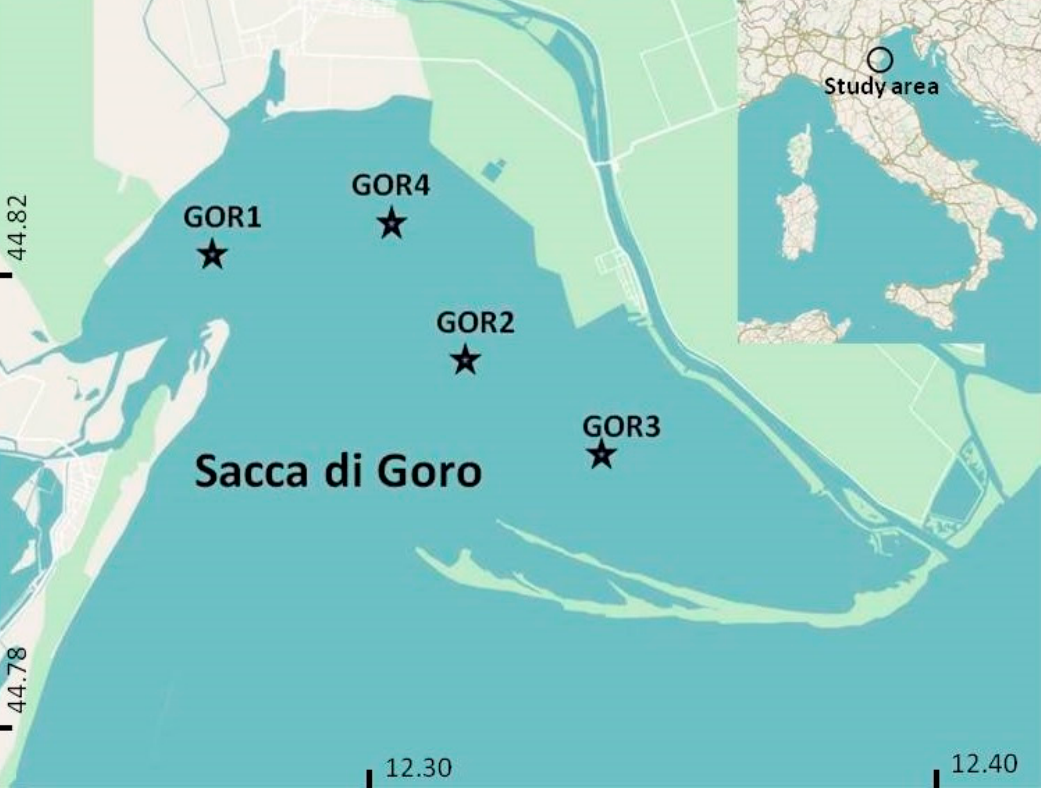
Figure 1. Map of the studied area with sampling sites.